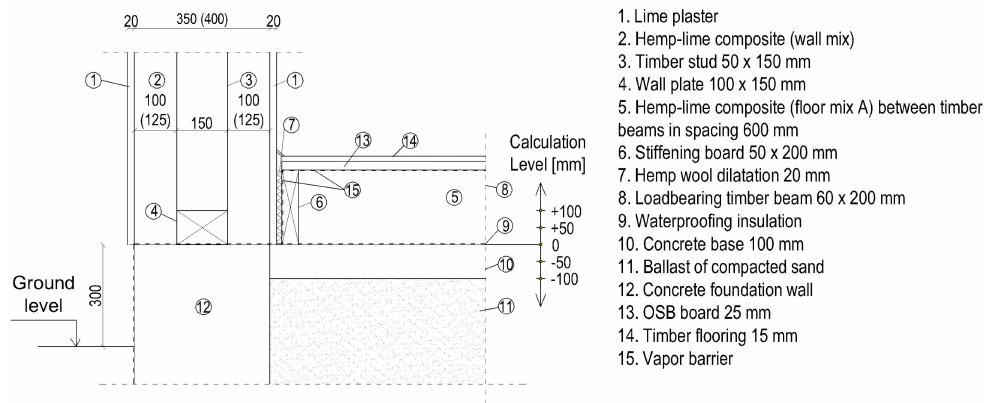
Figure 4. Ground floor junction with a floor on the ground with a structure in the form of timber